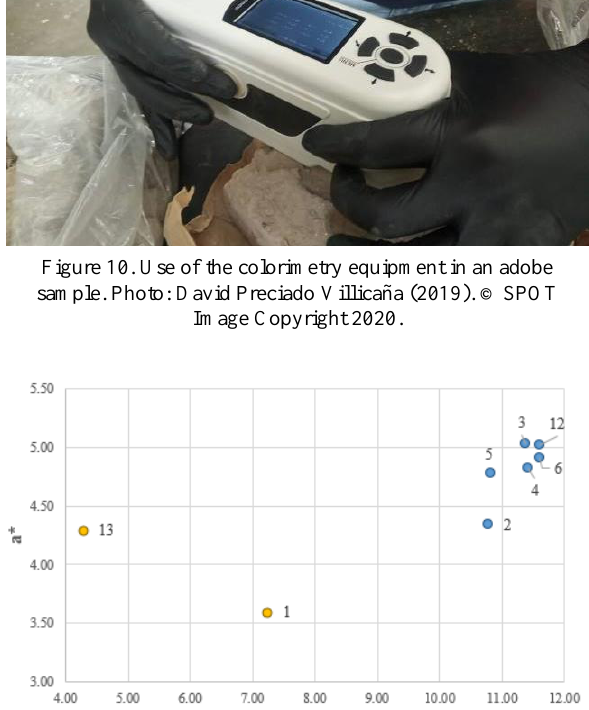
Figure 12. Adobe samples prepared for the compression test. Photo: Adrià Sánchez Calvillo